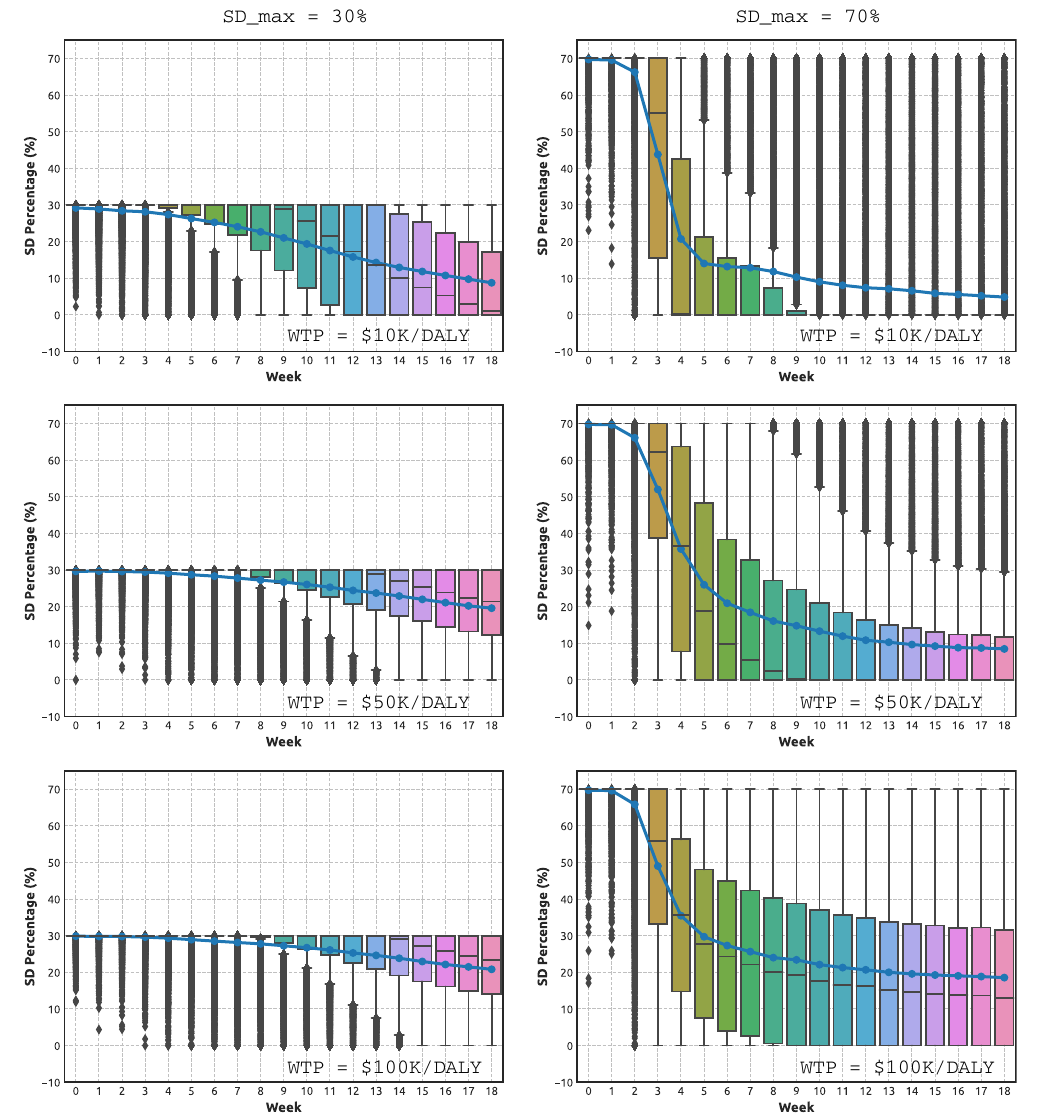
Figure 1. Adaptive NPIs, learned under different combinations of maximal SD levels SD max and WTP, over more than 14,000 simulations. Left: SD max = 0.3 . Right: SD max = 0.7 . Top: WTP is set at $10K per DALY. Middle: WTP is set at $50K per DALY. Bottom: WTP is set at $100K per DALY. Boxplots show the distribution of data over the quartiles, with box body capturing the mid-50% of the distribution. The curves shown with blue colour trace the mean values of the SD levels attained in each week. Outliers are shown in